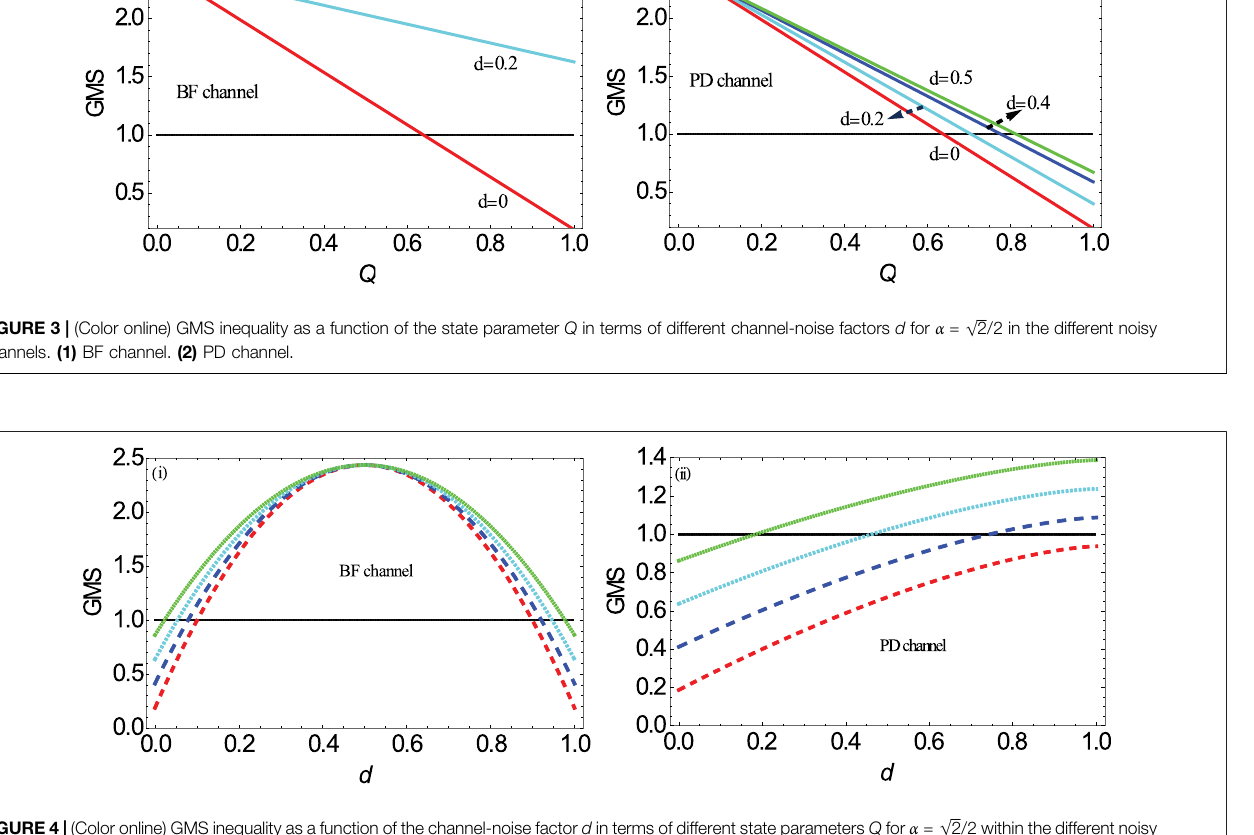
FIGURE 4 | (Color online) GMS inequality as a function of the channel-noise factor d in terms of different state parameters Q for α (cid:2) channels. (i) BF channel. (ii) PD channel. Here, Q (cid:2) 1 (red dashed lines), Q (cid:2) 0 . 9 (blue dashed lines), Q (cid:2) 0 . 8 (cyan dashed lines), and Q (cid:2) 0 . 7 (green dashed lines).